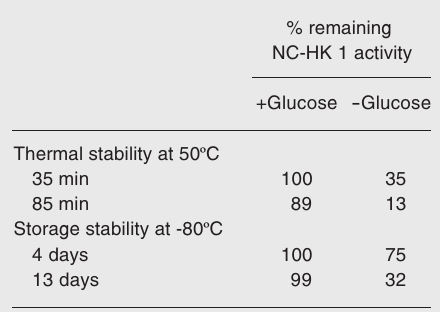
Table 2. Thermal and storage stability of NC-HK 1 activity from the DEAE column.